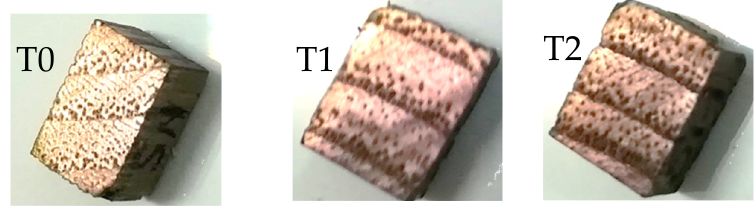
Figure 5. The gold-coated samples prepared for scanning electron microscope (SEM).